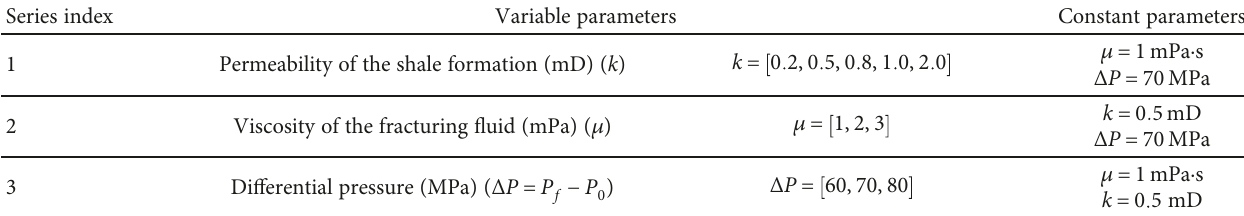
Table 1: Numerical modelling series and their modelling parameters.